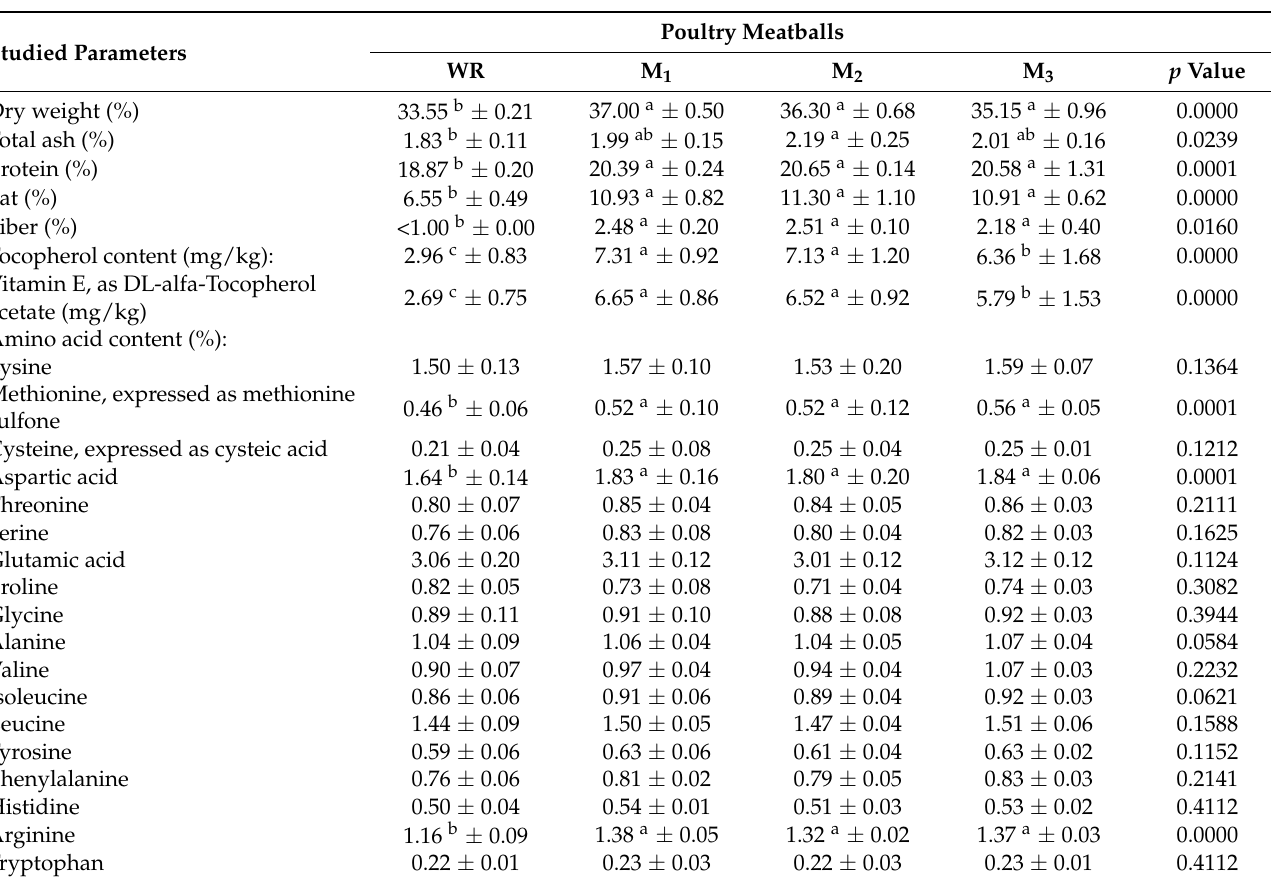
Table 3. Effect of adding a mixture of linseed, amaranth and hemp seeds on the chemical composition of poultry meatballs (x ±